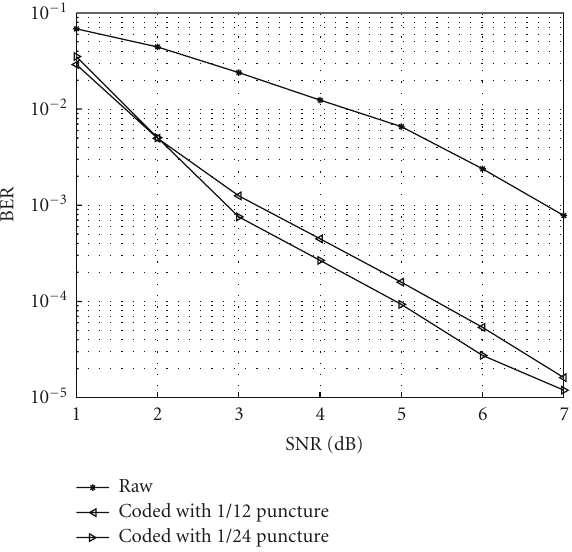
Figure 6: Average BER versus E b /N 0 for LO-MAC in Rician fading channel ( K = 7dB, f d = 20Hz).